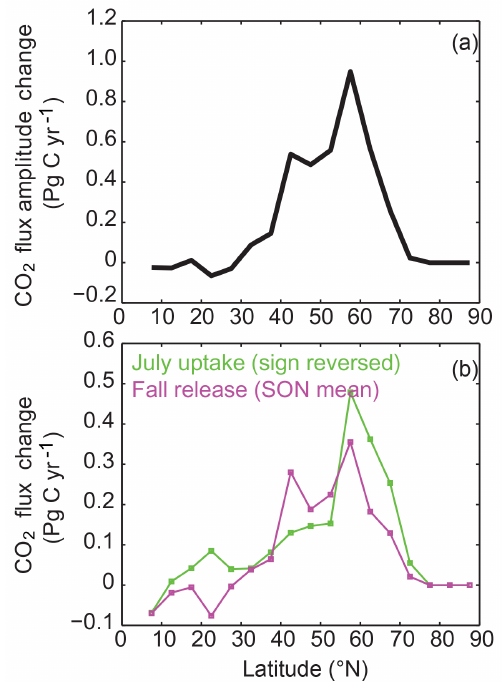
Figure 7. Latitudinal gradients in the land CO 2 fluxes from the Jena s85 inversion in 5 degree bands. (a) An estimate of the change in the annual CO 2 seasonal flux amplitude (PgCyr − 1 ) by subtracting the July from the SON fluxes at 5 degree latitude bands. Positive values reflect an increase in the peak-to-trough flux amplitude. (b) Green is the difference between the 2007–2011 mean and the 1983–1989 mean in the July CO 2 uptake with the sign reversed (here positive is uptake by the biosphere) and magenta is the difference in the mean of September–November fall CO 2 release with conventional sign (positive is release of CO 2 to the